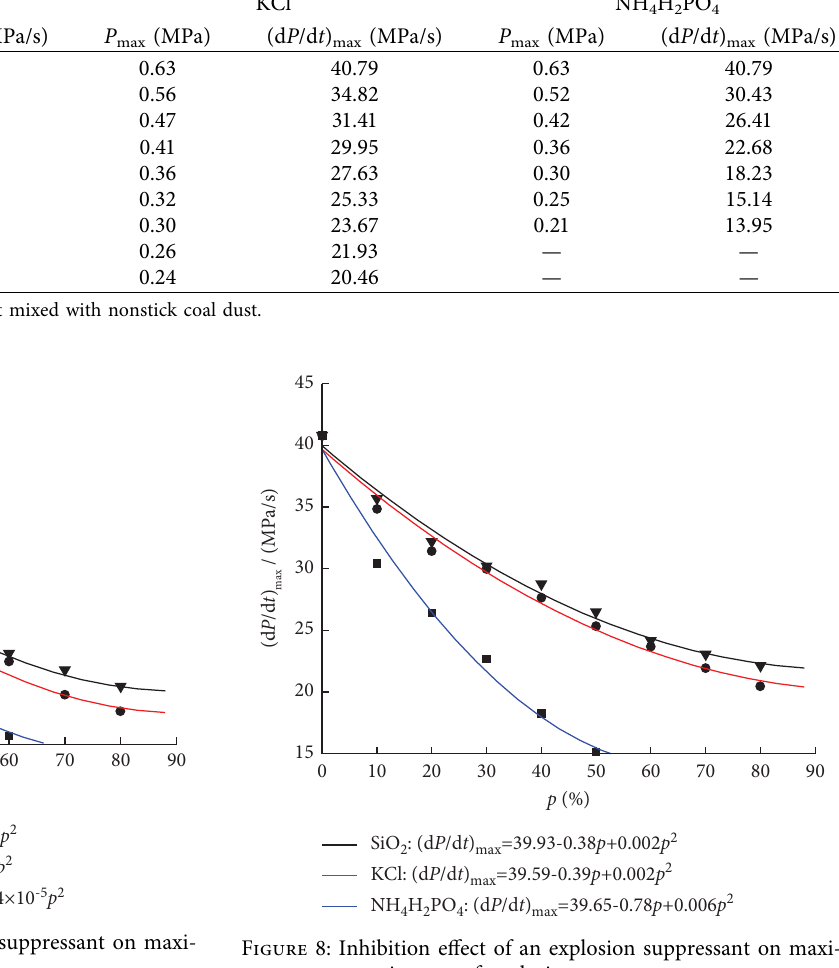
Table 5: Inhibition of an explosion suppressant on the explosion pressure of nonstick coal dust.